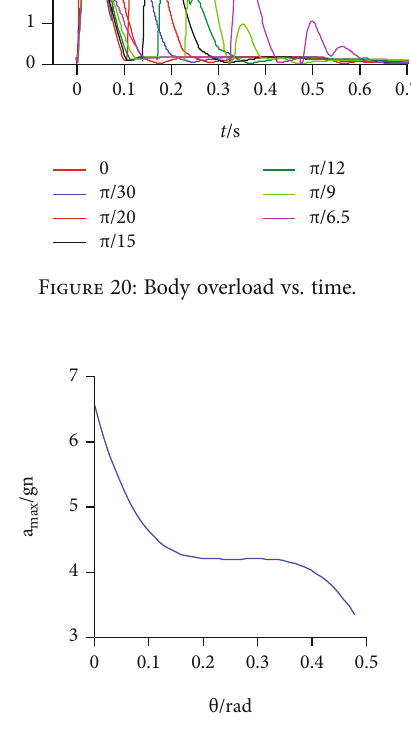
Figure 22: The maximum force of the primary strut 1 varies with the lunar inclination.